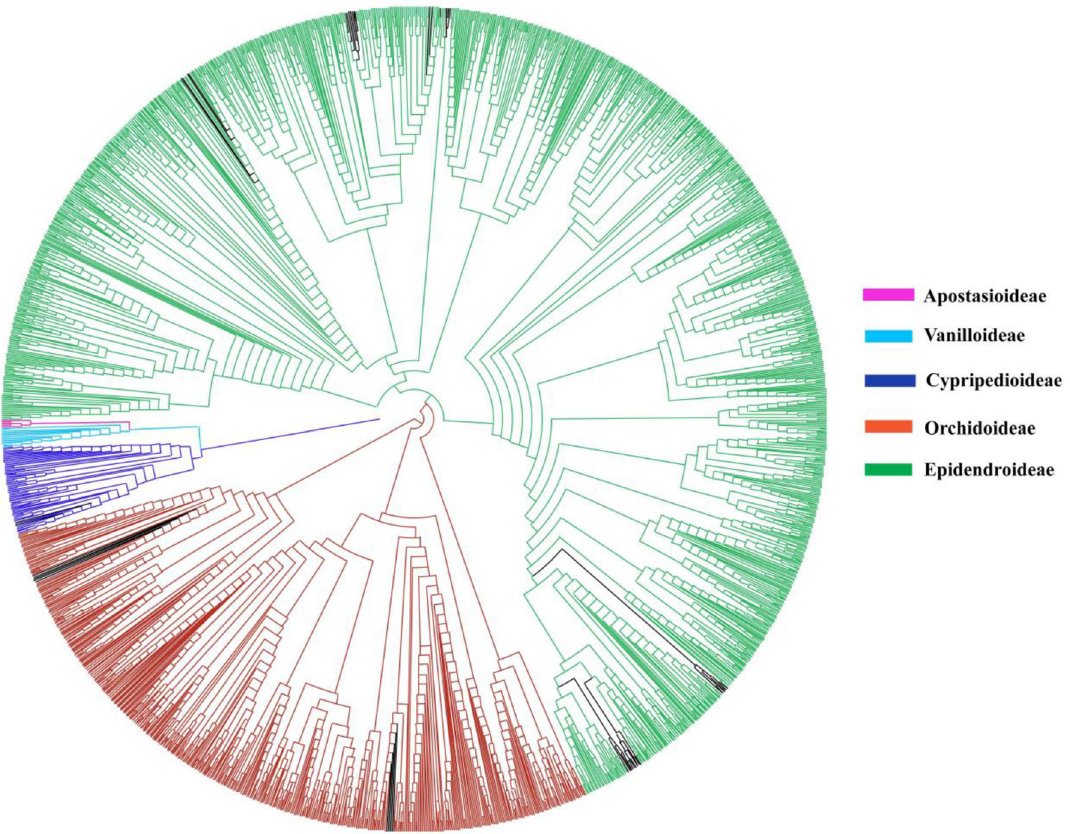
Figure 4. Neighbour-joining tree based on the ITS barcode. Coloured clades (except black) represent species that were correctly identified, and different sub-families are colour-coded. Black clades represent species that were not identified successfully. Details are included in Fig.